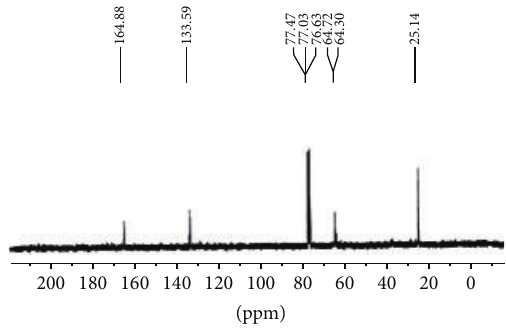
Figure 3: 13 C-NMR spectrum of copolyester PIFB.